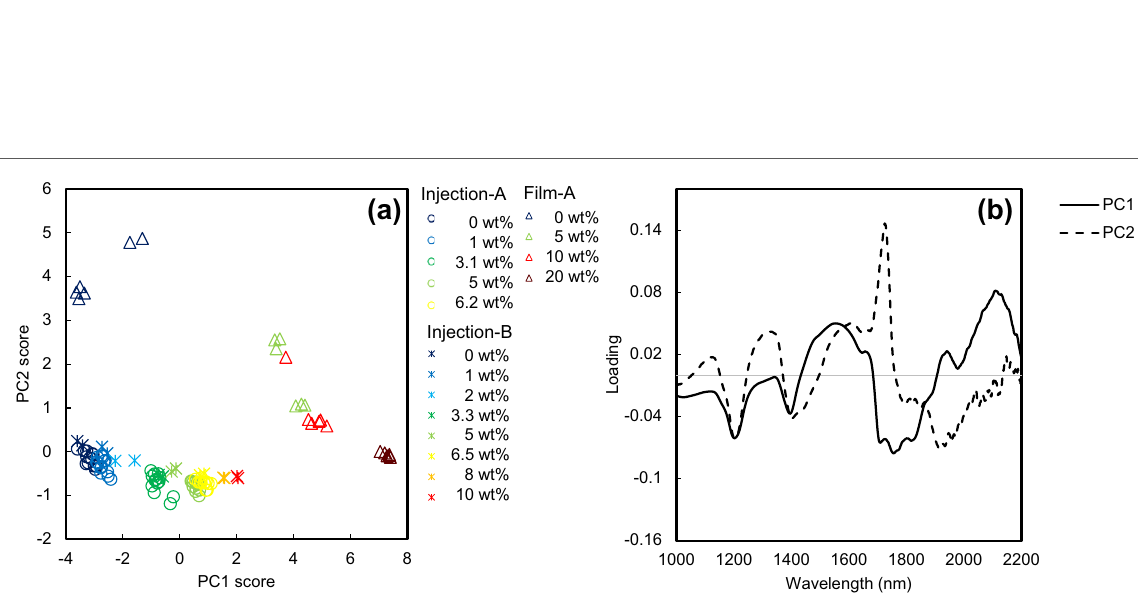
Fig. 3 The result of principal component analysis (PCA) for SNV-NIR spectra with all CNF/PP composites: a principal component (PC)1 and PC2 score plots, b loading plots of PC1 and PC2. The details of sample conditions are shown in Table